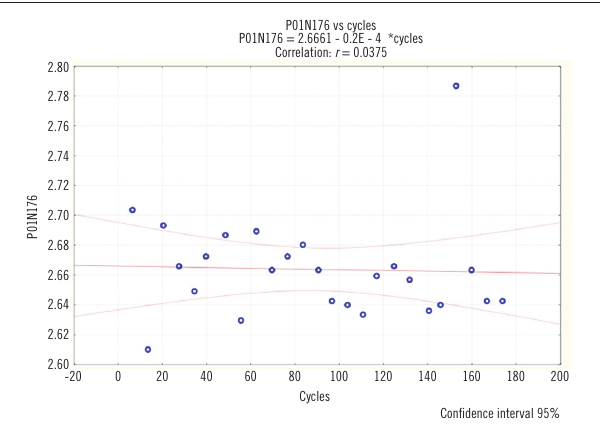
figurE 1 − Linear regression of the IQC anti-treponemal P01N176 batch based on 174 cycles of F/T IQC: internal quality control; F/T: freeze/thaw.